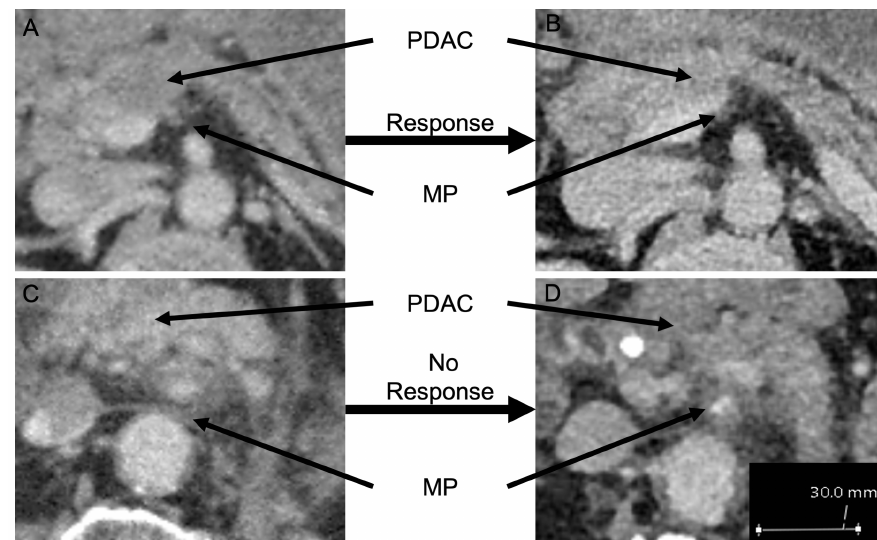
Figure 1. MDCT slides of PDAC patients prior to and after neoadjuvant therapy (Patient 1: slide ( A , B ), Patient 2: slide ( C , D )). ( A ) MDCT slide prior to neoadjuvant therapy with MPS. ( B ) MDCT slide after neoadjuvant therapy and treatment response without MPS. ( C ) MDCT slide prior to neoadjuvant therapy with MPS. ( D ) MDCT slide after neoadjuvant therapy without treatment response. (MDCT: multiphasic computed tomography, MPS: mesopancreatic fat stranding). Patient 1: ypT2N1M0G2R0CRM − ; Patient 2: